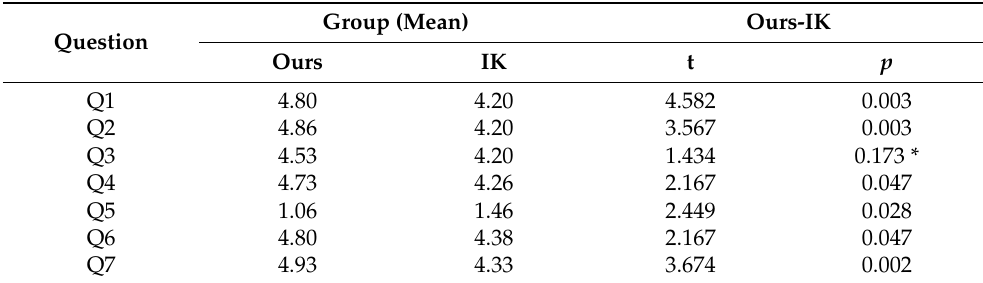
Table 9. Statistical analysis of questionnaire of the archery game under our method and the IK method. * marks the questions with insignificant differences.